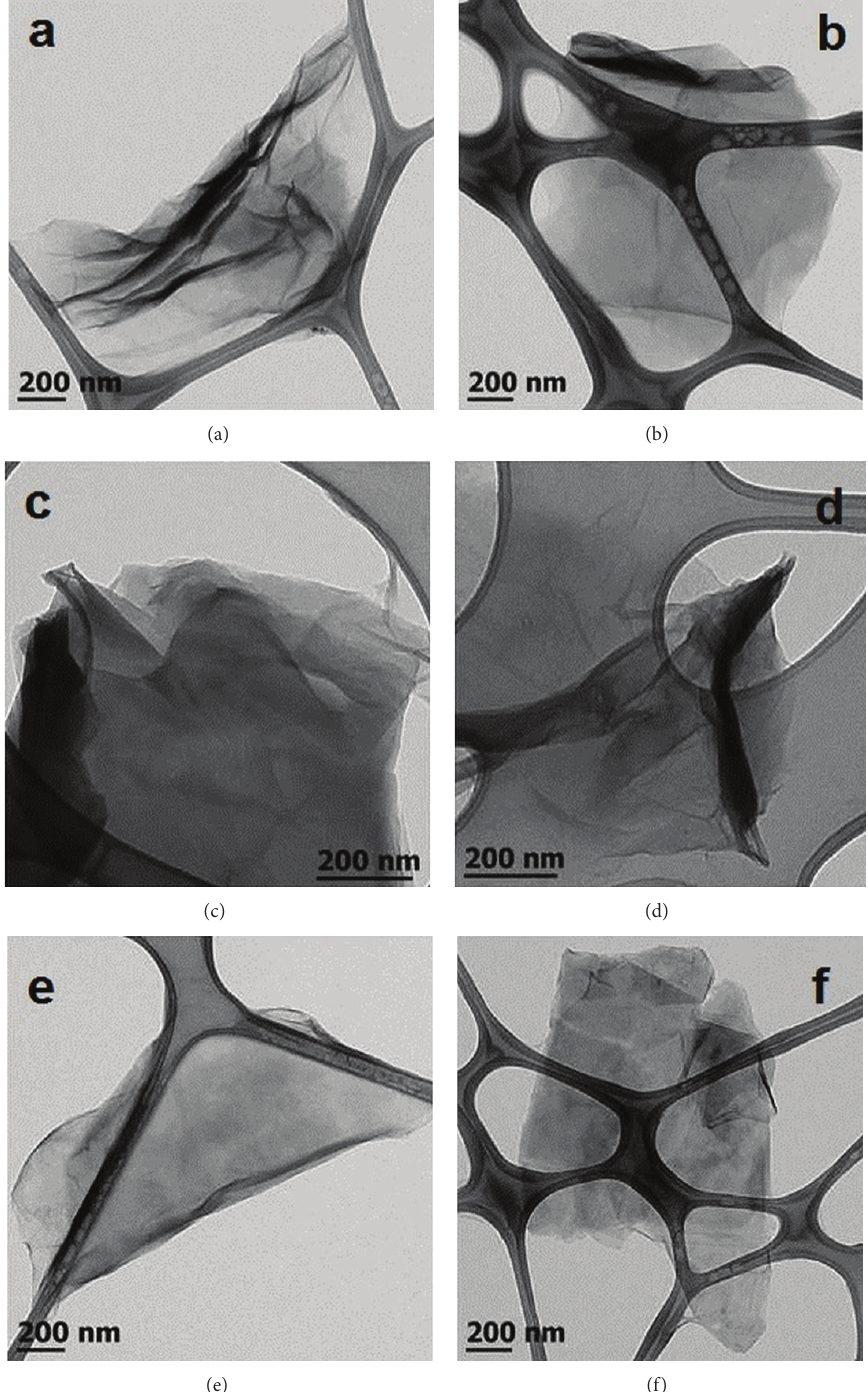
Figure 3: TEM micrographs of (a) GEO-2-55, (b) GEO-4-55, (c) GEO-6-55, (d) GEO-2-65, (e) GEO-4-65, and (f) GEO-6-65.